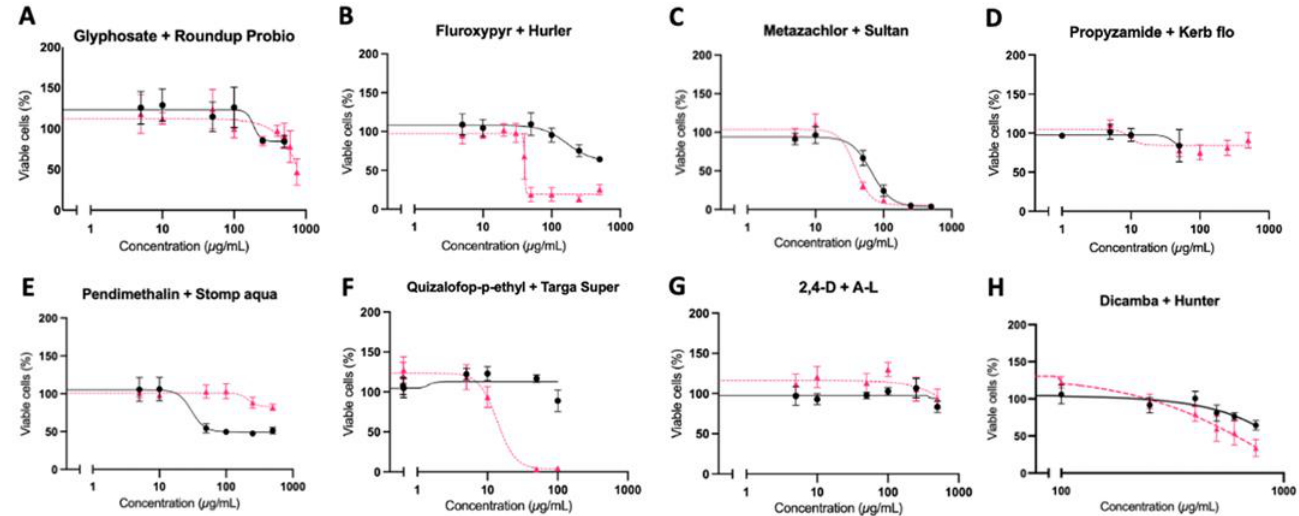
Figure 2. Differential cytotoxicity of herbicide active principles and their representative corresponding commercial formulations on human immortalised fibroblast cells using an MTT assay. Concentrations in µg/mL are dilutions of each active ingredient (black line) and formulation (pink line). The standard error of the mean (SEM) is shown in all instances (n = 15).